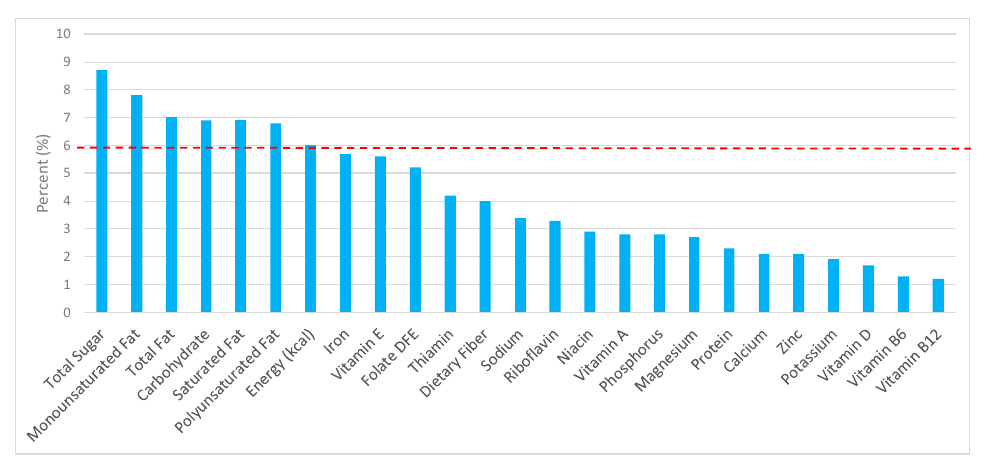
Figure 10. Sweet bakery products as sources of energy and nutrients using NHANES 2009–2012, for females. Data are for adult females aged ≥ 19 years of age ( n = 5349), Day 1 intakes; dashed red line represents the percentage of energy provided and nutrients that surpass energy (kcal) contribution. Thus, nutrients above the dashed red line show the food category provides a greater percentage in the diet to showcase meaningful nutrient density in the diet per day.